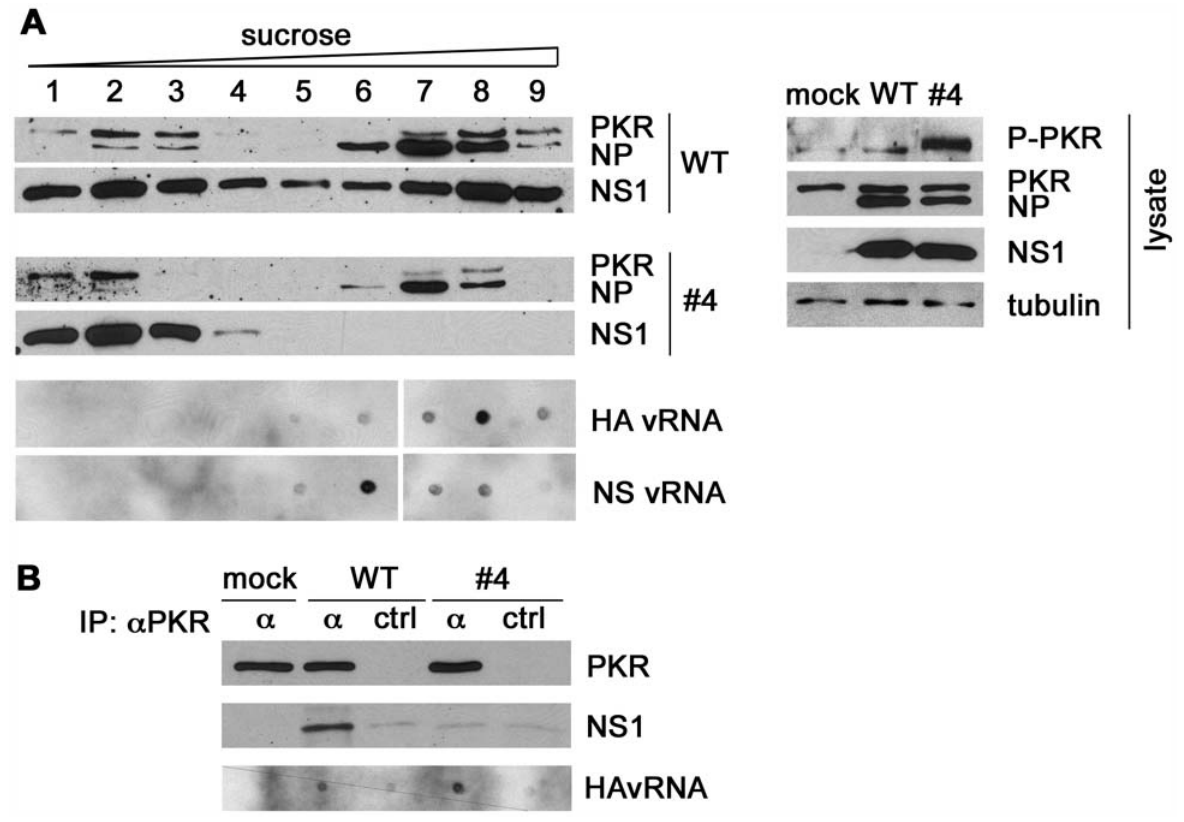
Figure 3. NS1 WT but not dsRNA-binding deficient NS1 protein co-sediments with PKR and vRNP upon density gradient centrifugation. (A) A549 cells were infected with WT virus or mutant virus # 4 at an MOI of 1. Cells were lyzed 12 hours p.i. and subjected to centrifugation through a continuous 5 to 50% sucrose gradient. 16 fractions were taken from top to bottom. Fractions 1 to 9 were analyzed by immunoblotting with antibodies specific for PKR and the viral NP and NS1 proteins. Also, RNA was extracted from gradient fractions 1 to 9 and was subjected to dot blot hybridization with probes specific for HA vRNA and NS vRNA, respectively (panels ‘‘HA and NS vRNA’’). Whole cell lysates were analyzed by immunoblotting with antibodies specific for phospho-PKR, total PKR, viral NP, viral NS1 and tubulin as indicated (right panel,‘‘lysate’’). (B) A549 cells were mock treated or infected with WT virus or virus mutant # 4 as described in panel A. Lysates were prepared and subjected to immunoprecipitation with anti-PKR ( a ) or control antibody (ctrl). The precipitated complexes were analyzed by immunoblotting for PKR and NS1 proteins. RNA was isolated from an identical set of PKR immunoprecipitates of cells infected with the mutant virus and subjected to dot blot analysis with an RNA-probe specific for HA